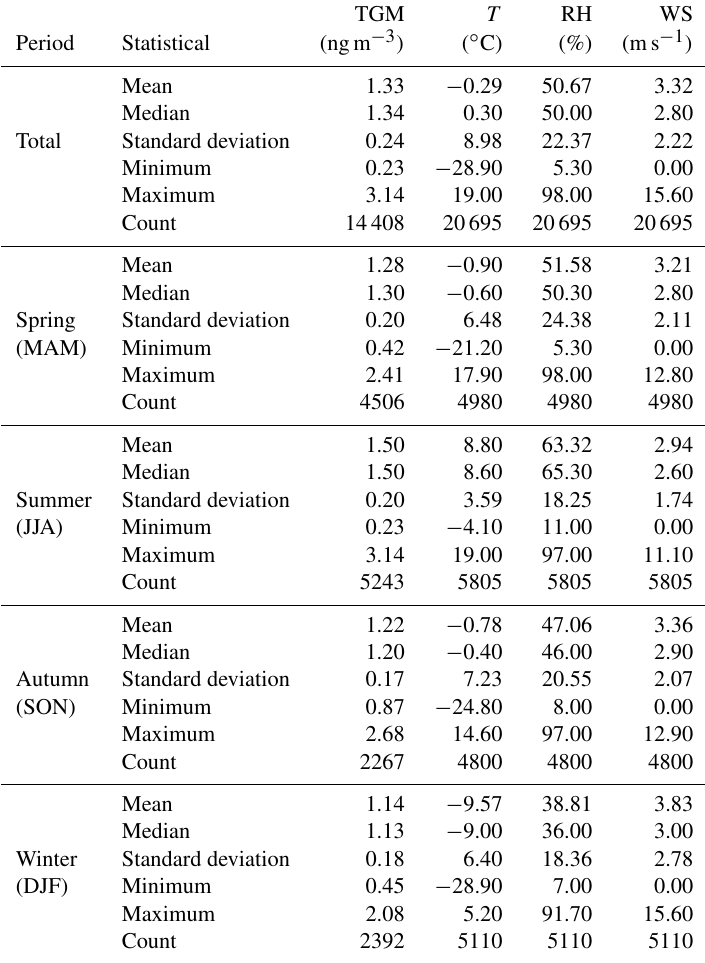
Table 1. The statistics of TGM and meteorological variables in different seasons at Nam Co Station during the measurement period (2012–